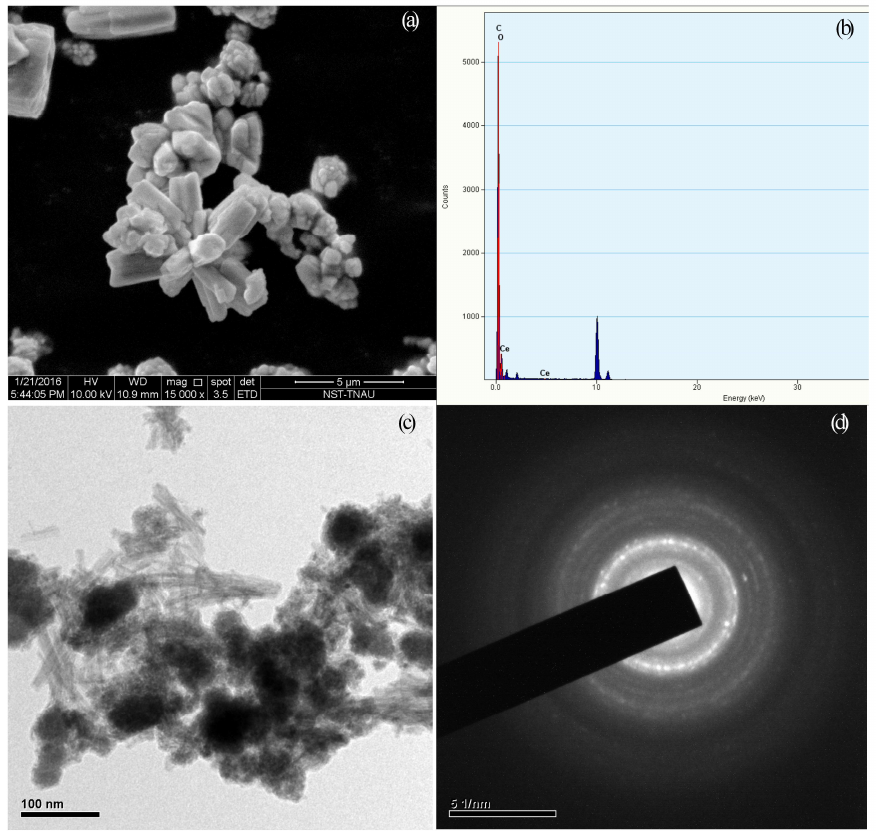
Figure 1. Representative SEM and TEM images of synthesized nanoceria. ( a ) SEM, ( b ) EDX analysis, ( c ) TEM, and ( d ) SAED pattern of nanoceria.